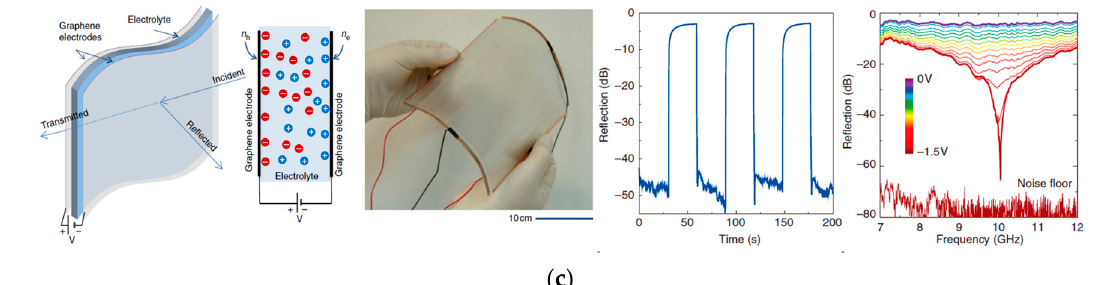
Figure 6. Tunable electromagnetic properties and gate configurations of graphene. ( a ) Calculated spectral absorption of single − layer graphene with various sheet resistance from microwave to visible frequencies and the corresponding electronic band structure [111]. ( b ) Conventional gate configurations for graphene, including top gate, bottom gate, and EDLC [97]. Copyright John Wiley and Sons, 2020. ( c ) Adaptive microwave absorber with two graphene electrodes sandwiching ion liquid [111]. The modulation band is from 7 to 12 GHz, and the response time of modulation is around 0.3 s.